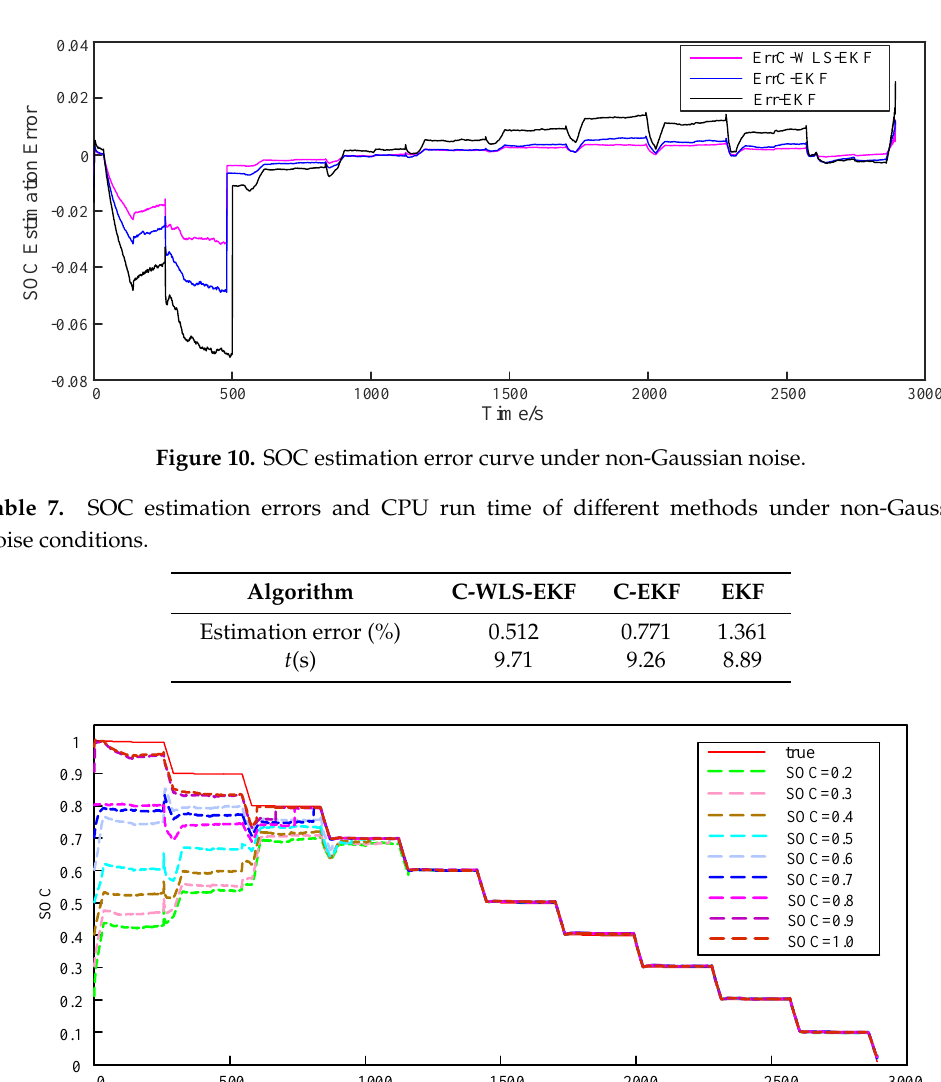
Figure 9. SOC comparison of different algorithm estimation results when the initial value of SOC = 1.